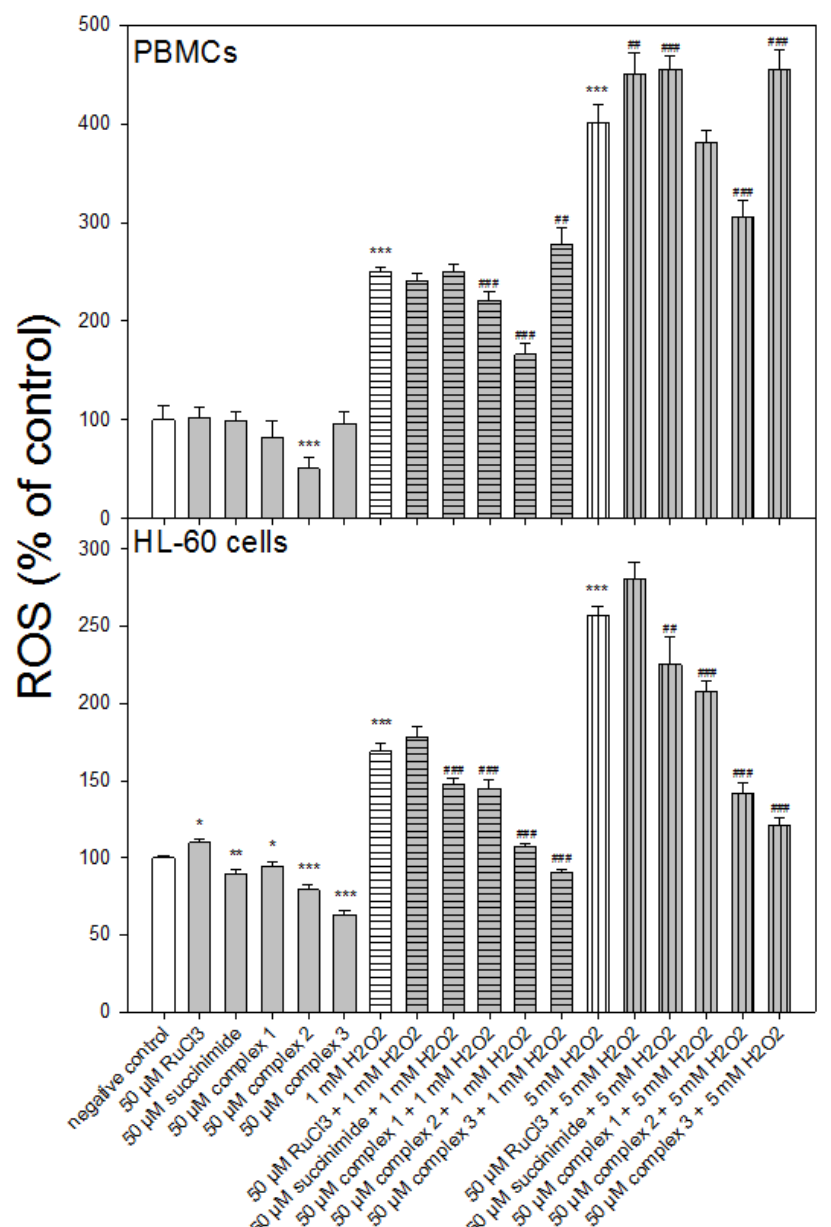
Figure 4. Changes in reactive oxygen species (ROS) level in PBMCs and HL-60 cells pre-incubated with ruthenium complexes 1 – 3 at 50 μM for 24 h at 37 °C and then incubated with 1 mM or 5 mM H 2 O 2 at 37 °C. Each value represents the mean ± SD, n = 6; * p < 0.05, ** p < 0.01, *** p < 0.001 vs. negative control; ## p < 0.01, ### p < 0.001 vs. H 2 O 2 .